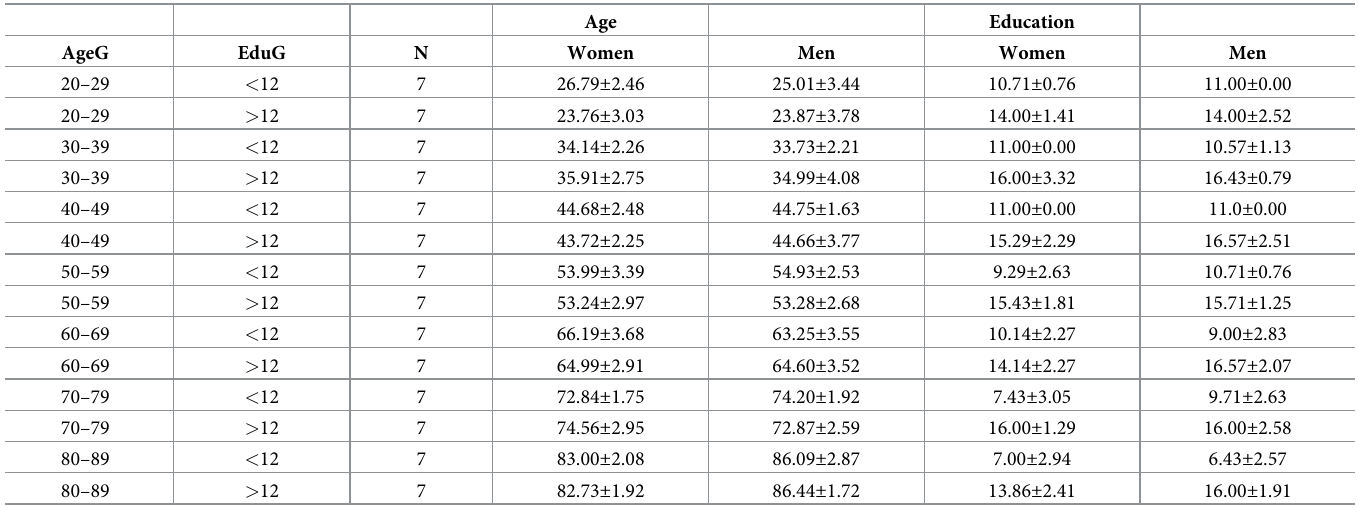
Table 3. Characteristics of healthy